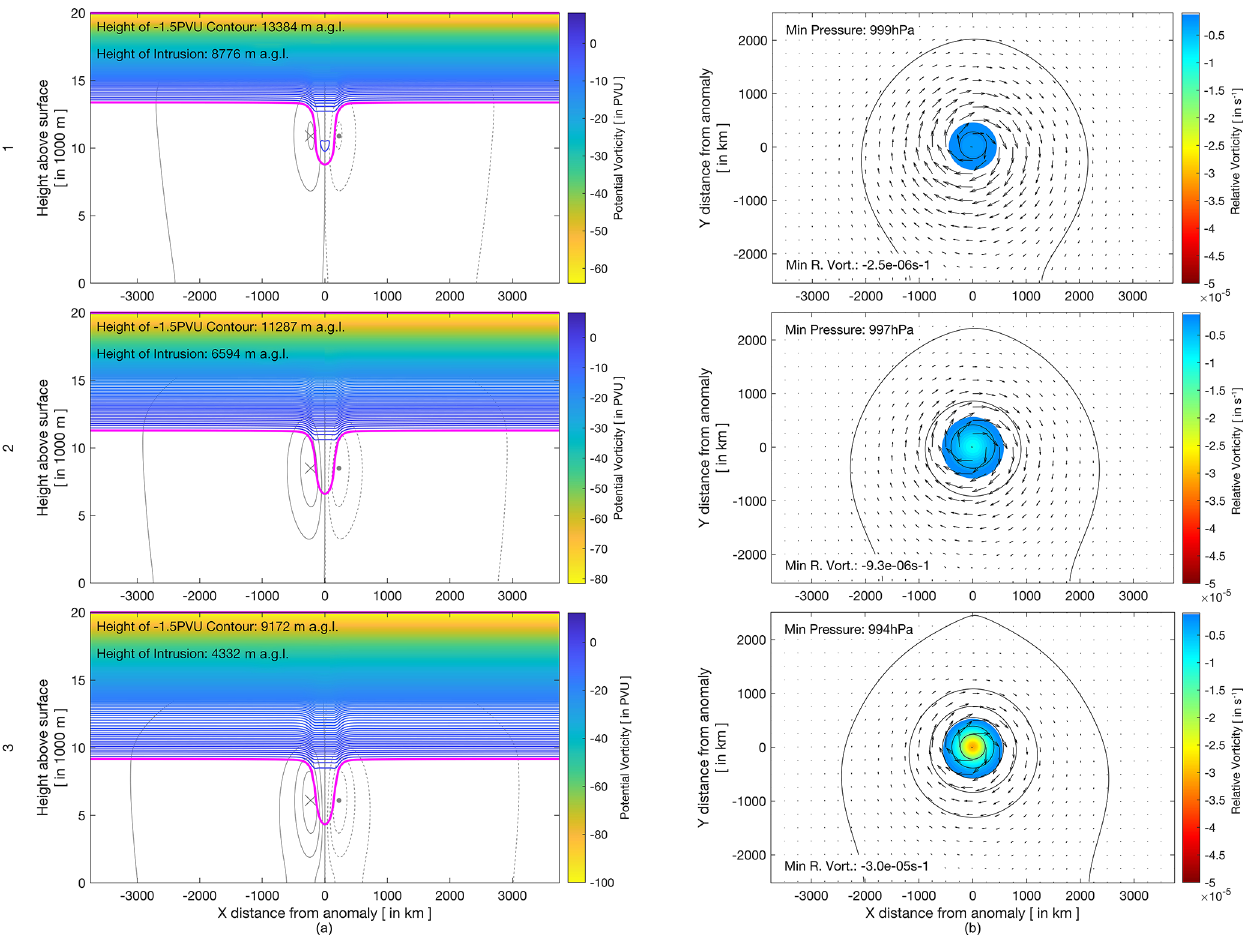
Figure 9. Same as in Fig. 7 with the exception that in this case the anomaly radial height is kept constant at 5000m with varying tropopause heights of 15000m (row 1), 12500m (row 2), as in Experiment 0, and 10000m (row